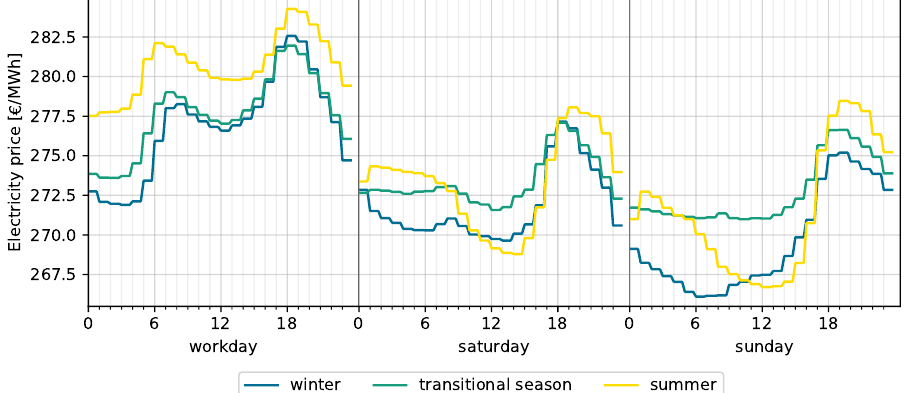
Figure 5. Average electricity price per type of day and